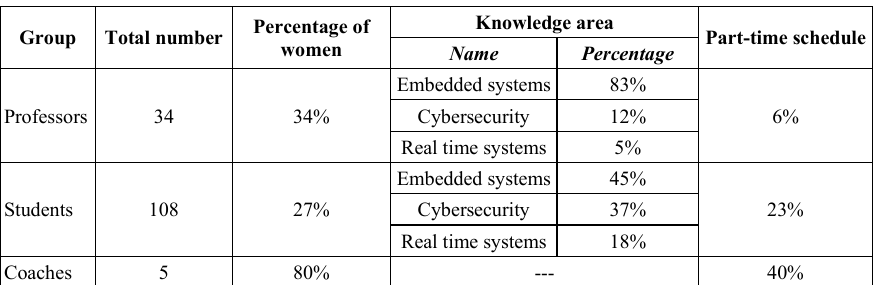
Table 1. Participants’ characteristics (work